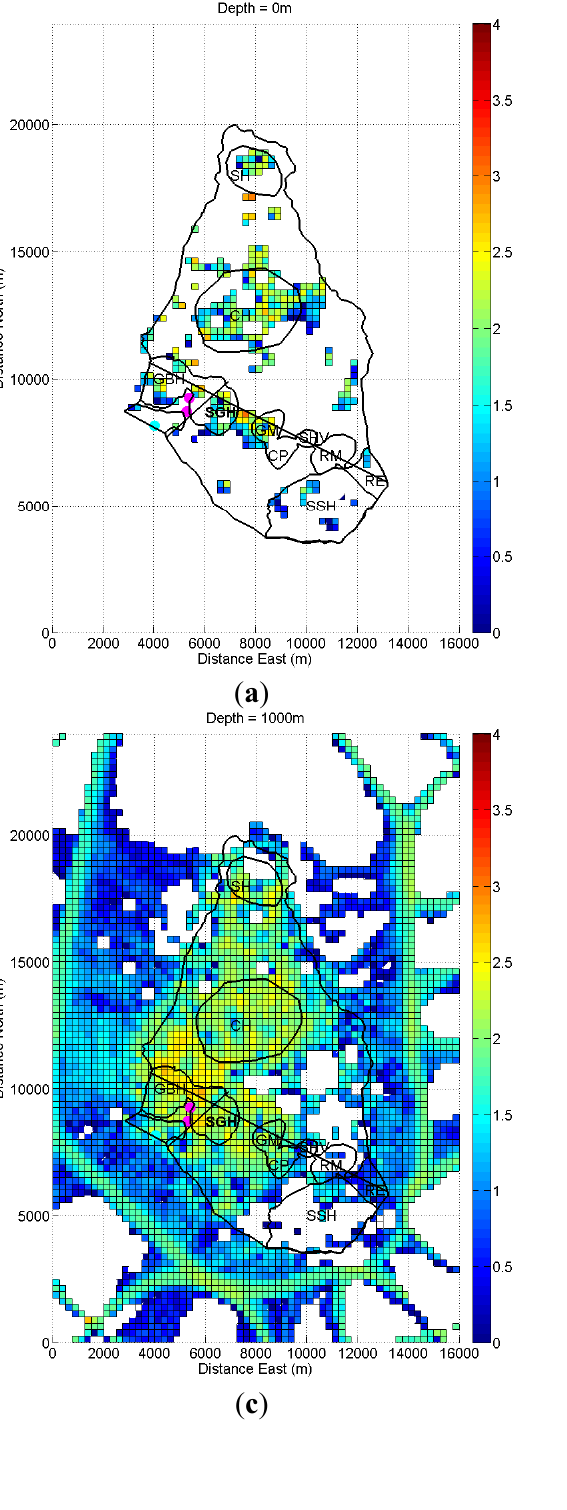
Figure A4. Ray hit counts for the tomographic inversion domain including. The panels show the number of rays that pass through 250 m × 250 m × 250 m boxes at ( a ) 0 m; ( b ) 500 m; ( c ) 1000 m; ( d ) 2000 m and ( e ) 3000 m depth. Only the center portion of the tomography box is plotted, with the outline of Montserrat in black. Colors indicate the log 10 of the number of rays that track through each